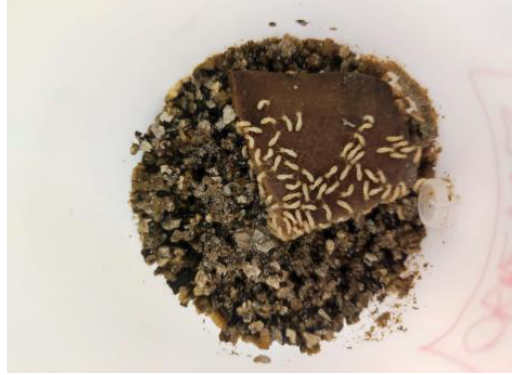
Figure 7. Reticulitermes termites before